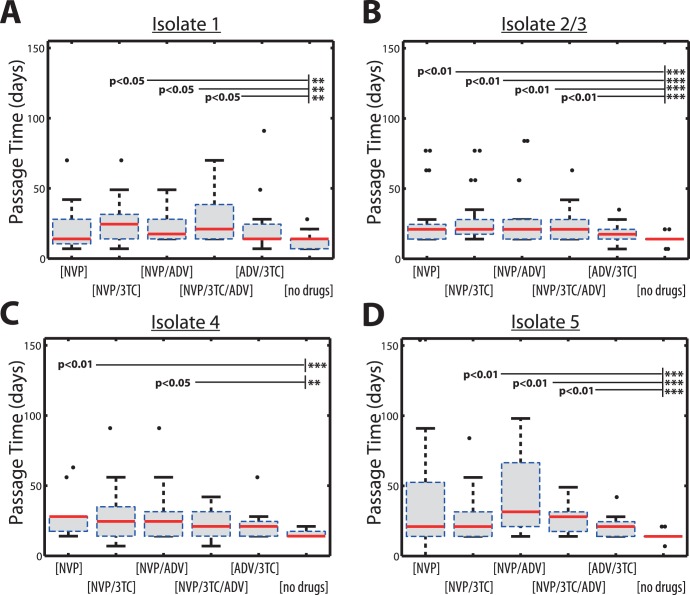
Box plot of single passage times for virus isolate #1, #2/3, #4 & #5 during experimental set-ups A–F as indicated on the x-axis.The solid red horizontal lines indicate the respective median passage times, whereas the boxes surrounding them indicate the range encompassed by the 25th and 75th percentiles. The whiskers denote the most extreme data points, which are not considered outliers and the black dots indicate outliers. A: Viral passage times for isolate #1. B: Viral passage times for isolate #2&3 (combined). C: Viral passage times for isolate #4. D: Viral passage times for isolate #5.